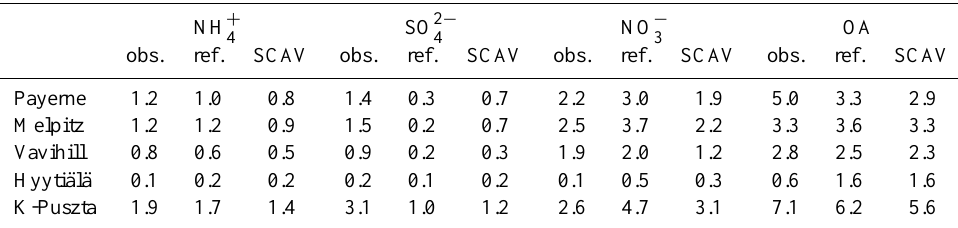
Table 5. Time-averaged NR − PM 1 masses (µgm − 3 ) corresponding to the pie charts in Figure 6a, b for observations (obs.), the reference simulation (ref.) and including SCAV (SCAV).